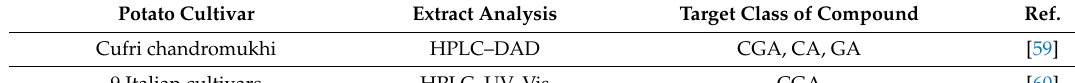
Table 3. Analytical methods used for phenolic compound extracts from